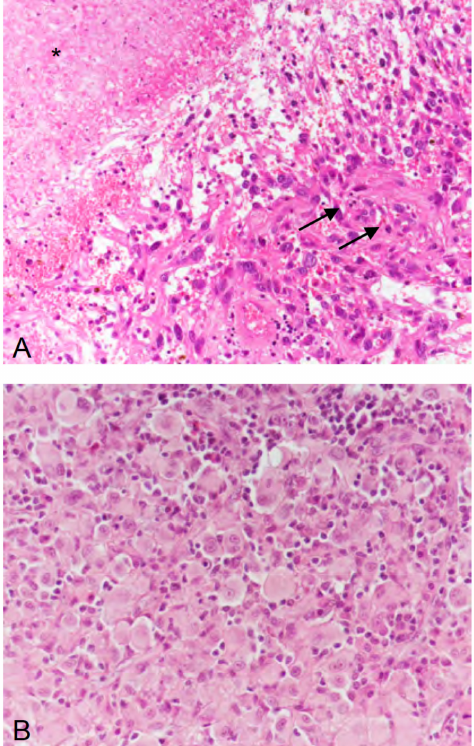
Figure 3. ( A ) In 2007, the second recurrence of the tumor exhibited microvascular proliferation (arrows) and necrosis (asterisk), thus, corresponding to a glioblastoma (WHO grade IV). ( B ) In 2014, the fifth recurrence of the tumor was dominated by epithelioid differentiated glial tumor cells, thus, corresponding, to epithelioid glioblastoma (WHO grade IV). ( A , B ) hematoxylin and eosin staining; original magnification ×